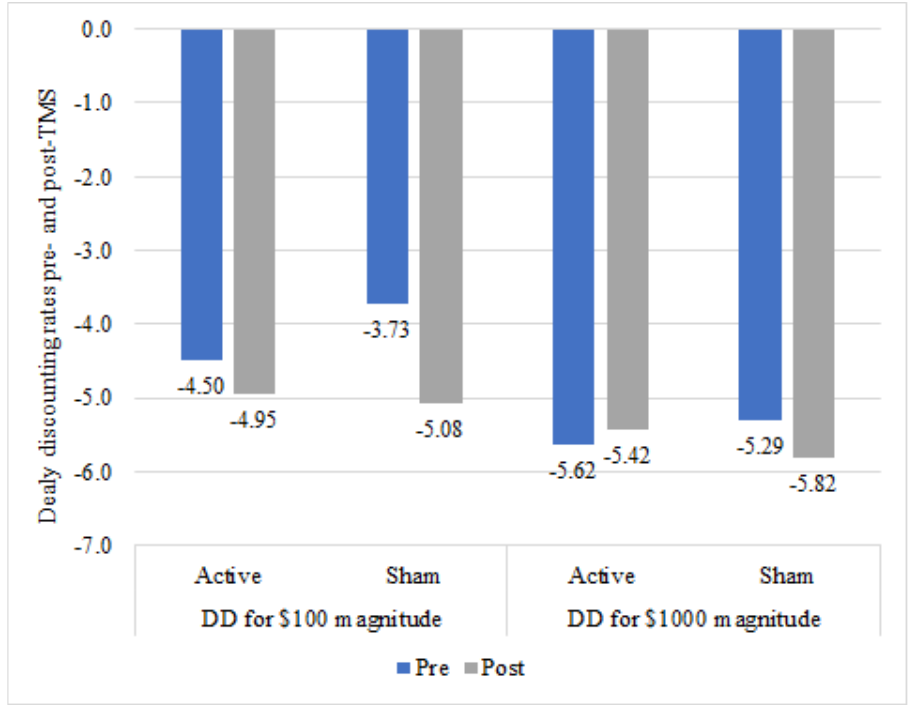
Figure 4. Pre- and post-TMS intervention delay discounting values by condition. Paired-samples t-tests revealed that, across conditions, delay discounting rates significantly decreased for the USD 100, but not for USD 1000 magnitudes (USD 100: t = − 3.12 p < 0.01, M pre = − 4.11 vs. M post = − 5.01; USD 1000: t = − 0.83, p = 0.41, M pre = − 5.46 vs. M post = − 5.62).